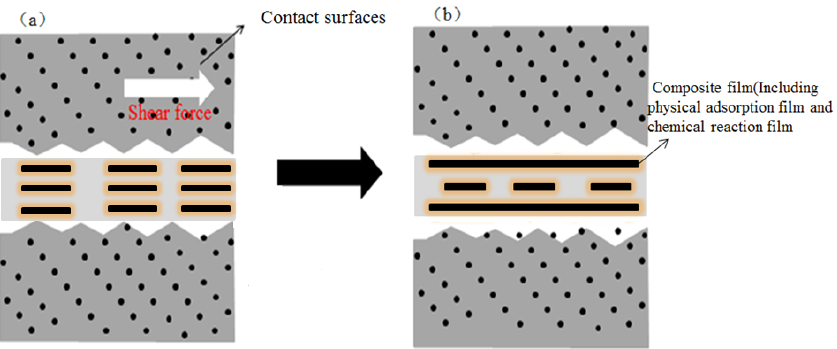
Figure 7. Schematic of the water lubrication mechanism of liquid graphene. ( a ) The individually dispersed graphene sheet on the contact surface; ( b ) during the sliding process, the individually dispersed graphene sheets can be rearranged on the surface to form a composite protective film, which effectively reduces friction and wear. Reproduced with permission from reference Yang et al. [115], Copyright 2017, Elsevier.